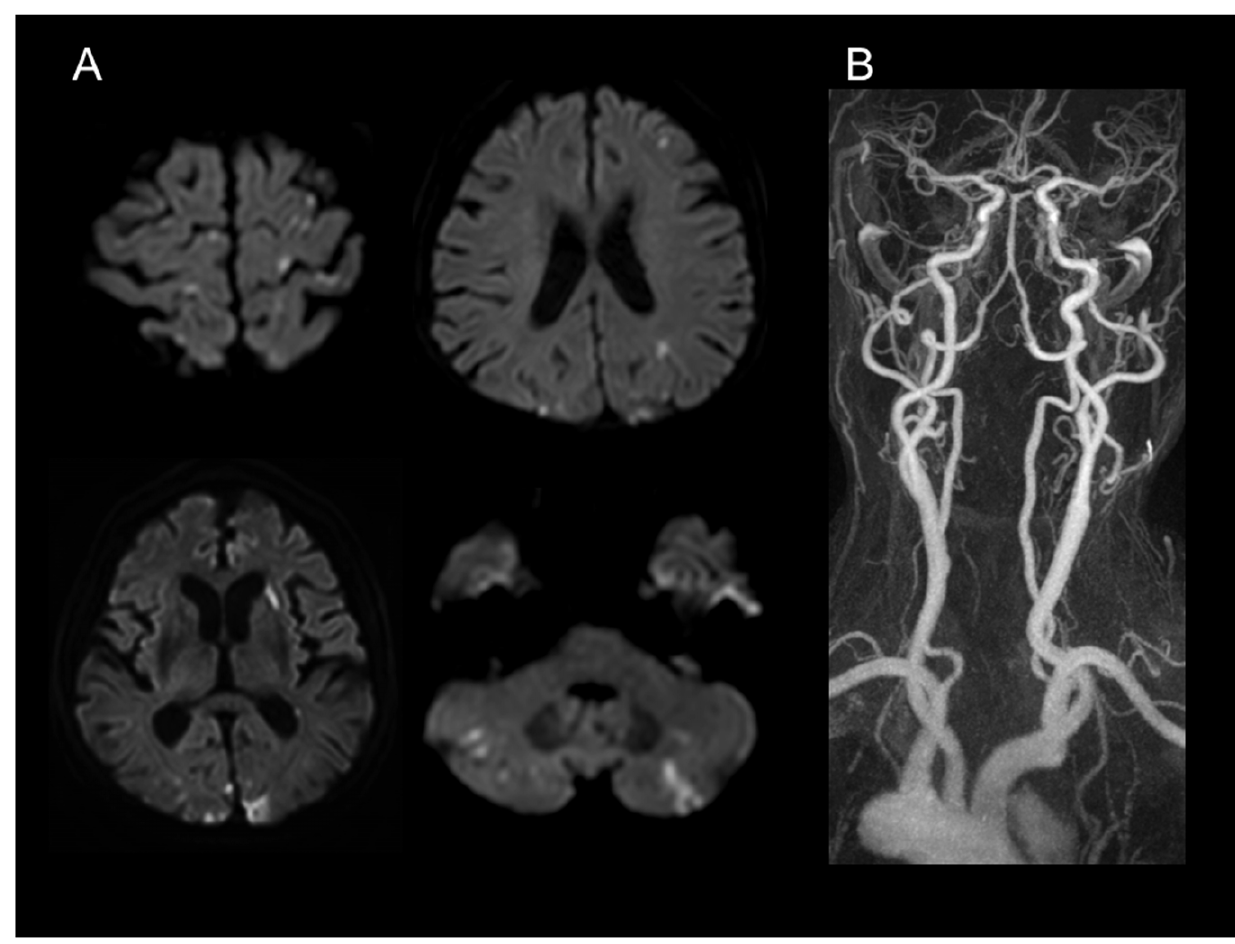
Figure 1. A typical example of cryptogenic stroke with active cancer (cancer-related stroke). The patient was a 55-year-old female, who was diagnosed with metastatic adenocarcinoma of lung one year ago. Neurologic examination revealed motor aphasia, right-central facial paralysis, and right hemiparesis. Initial D-dimer levels were 20.56 m g/mL. Diffusion-weighted MRI (A) shows multiple lesions involving multiple vascular territories. MR angiography (B) reveals no significant stenosis or occlusion of the craniocervical arterial vasculature. Comprehensive workup including transesophageal echocardiogram and 24-hour Holter monitoring demonstrated no sources of cardioembolism.